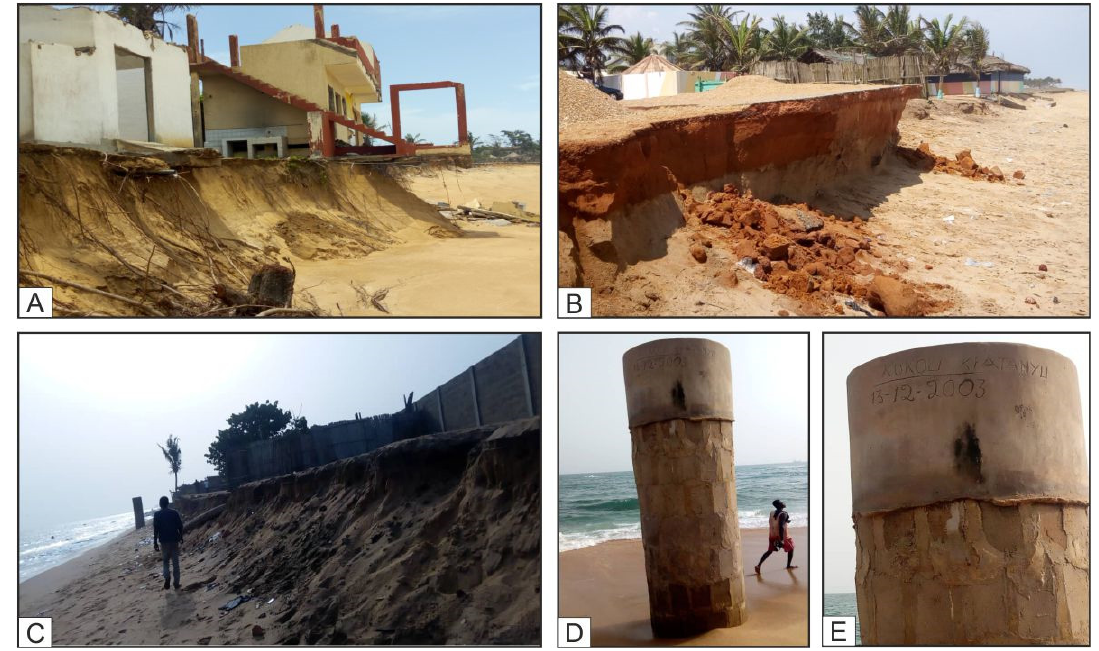
Figure 4. Significant examples ( A – E ) of the strong and active erosion processes along the eastern beach of Lomé (Photographs December 2019).